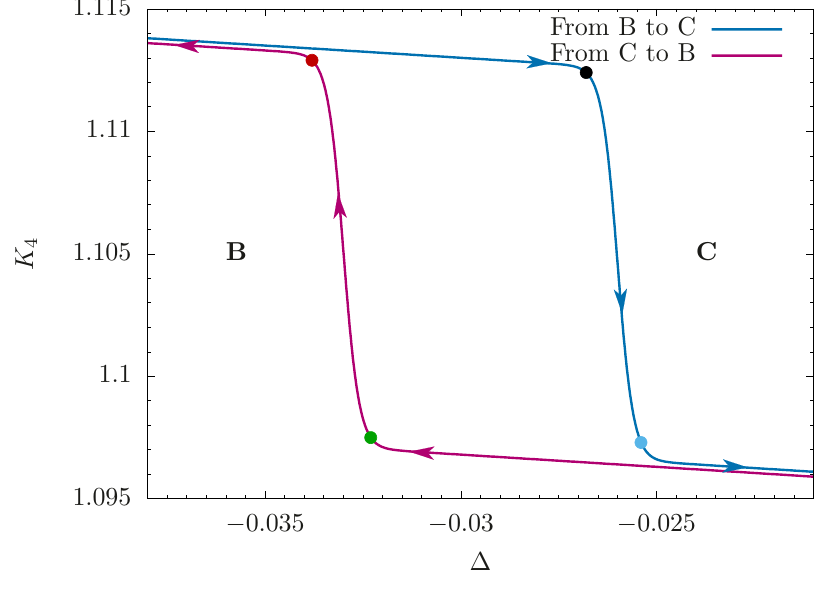
Figure 2 . The plot illustrates the hysteresis measured during simulations for the target volume (cid:22) N 41 = 160k. The green and blue dots correspond to the location of the phase C side of the phase-transition, while the red and black dots correspond to the location of the phase B side of the phase-transition. The same colors will be used in the next plots, where we compare results for di(cid:11)erent